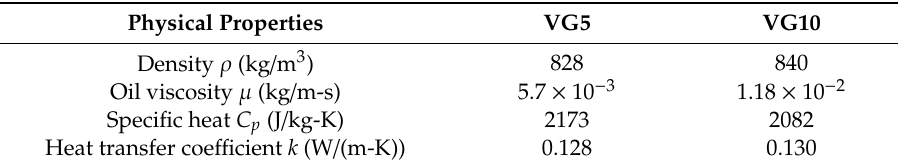
Table 1. Properties of VG5 and VG10 oil products.